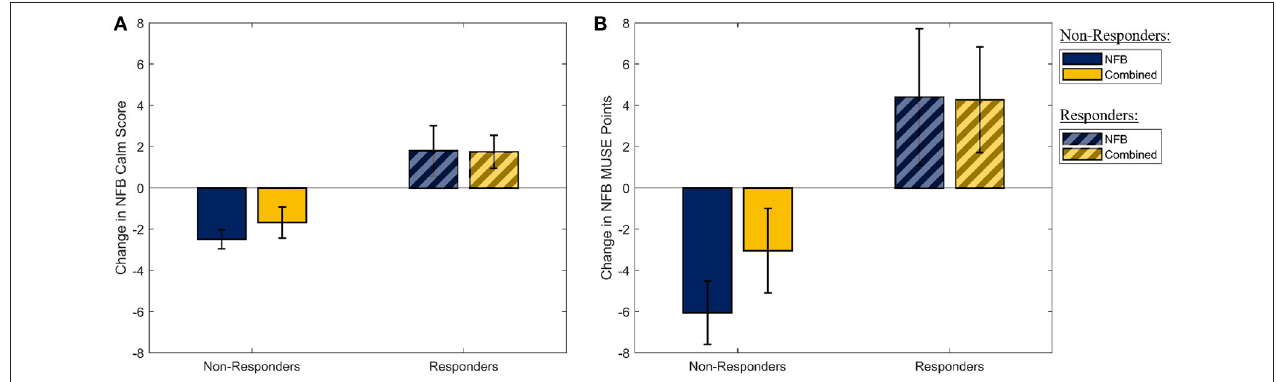
FIGURE 3 | The distribution of the two metrics used to determine NFB “Responders” and “Non-Responders.” (A) The mean slope of the amount of time participants spent in the “Calm” state during their mindfulness-like NFB training sessions. (B) The mean change in the MUSE points during each mindufulness-like NFB training sessions. Error bars shown are ± 1